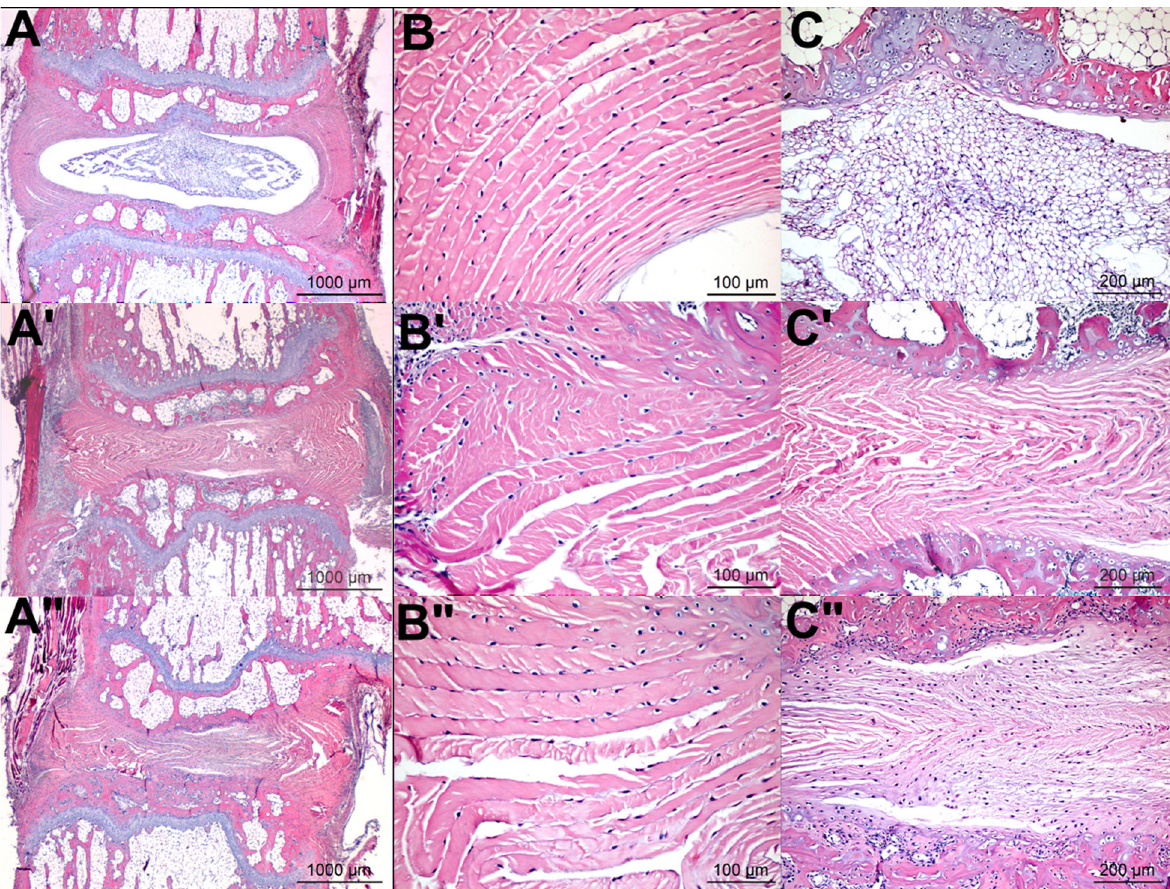
Figure 5. Representative sections stained with hematoxylin and eosin of intact control and punctured discs 7 or 30 days post-lesion. A , Intact control showing an unbroken annulus fibrosus with its border clearly defined and the nucleus pulposus comprising a significant disc area in the sagittal sections. B , Annulus fibrosus of an intact disc with well-opposed lamellae. C , Nucleus pulposus of a large intact disc with abundant material. Punctured disc 7 ( A 9 ) or 30 days ( A 0 ) after lesion showing poorly opposed lamellae and complete obliteration of the nucleus pulposus cavity. Annulus fibrosus of punctured discs with severe lamellar disorganization/fragmentation 7 ( B 9 ) or 30 days ( B 0 ) after lesion. Nucleus pulposus cavity of punctured discs without true nucleus pulposus cells replaced with fibrous material 7 ( C 9 ) or 30 days ( C 0 ) after